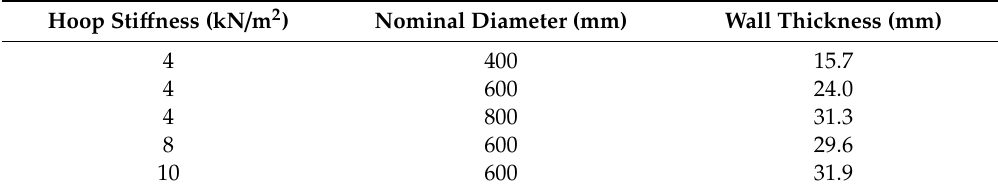
Table 1. Shape parameters of the simplified straight-walled pipe.